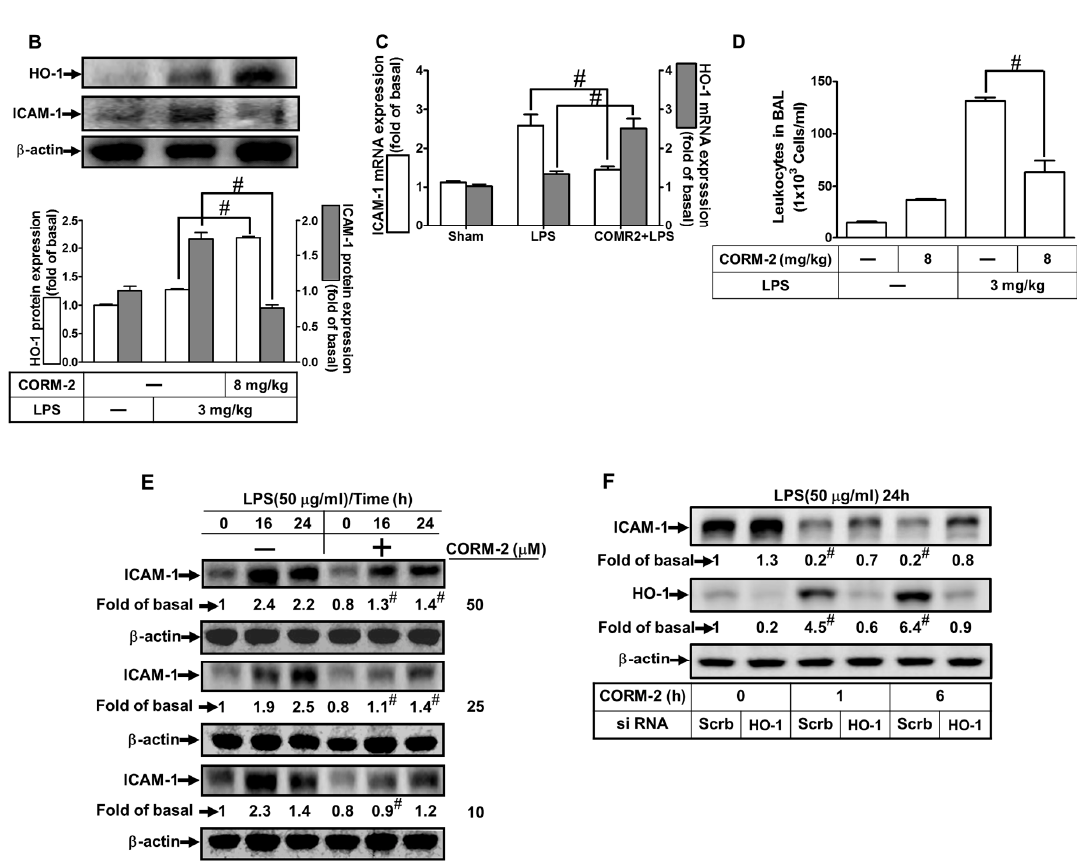
Figure 1. Induction of heme oxygenase (HO-1) by carbon monoxide-releasing molecule (CORM-2) suppresses intercellular adhesion molecule-1 (ICAM-1) expression and leukocyte infiltration in HTSMCs and mice. Institute of Cancer Research (ICR) mice were pretreated with CORM-2 (8 mg / kg of body weight) for 24 h, and then treated with lipopolysaccharide (LPS) (3 mg / kg of body weight). ( A ) H (hematoxylin) & E (Eosin) and immunohistochemical staining for α -smooth muscle actin ( α -SMA), ICAM-1, and HO-1 in serial section of the airway tissues from sham [0.1 mL of DMSO–PBS (phosphate-buffered saline) (1:100) with 0.1% ( w / v ) BSA (bovine serum albumin) treated mice], LPS (LPS-injected mice) and CORM-2 + LPS mice. The arrows indicate tracheal smooth muscle cells displayed with ICAM-1 and HO-1 expression. ( B , C ) Airway tissues were homogenized to extract proteins and mRNAs (messenger ribonucleic acids), and analyzed by ( B ) Western blot and ( C ) real-time PCR to determine the levels of HO-1, ICAM-1, and β -actin (served as an internal control) protein and mRNA expression, respectively. ( D ) BAL fluid was collected to count the number of leukocytes infiltration. ( E ) Human tracheal smooth muscle cells (HTSMCs) were pretreated without or with various concentrations of CORM-2 for 1 h and then incubated with LPS (50 µ g / mL) for the indicated time periods. The levels of ICAM-1 and β -actin were determined by Western blot. ( F ) Cells were transfected with scrambled (Scrb) or HO-1 siRNA (small interfering ribonucleic acid), incubated with CORM-2 (50 µ M) for 1 or 6 h, and then stimulated with LPS (50 µ g / mL) for 16 h. The levels of ICAM-1, HO-1, and β -actin protein were determined by western blot. Data are expressed as mean ± SEM of five independent experiments ( n = 5). # p < 0.05, as compared with the mice exposed to the indicated reagents. Data analysis and processing are described in the section “Statistical Analysis of Data”.